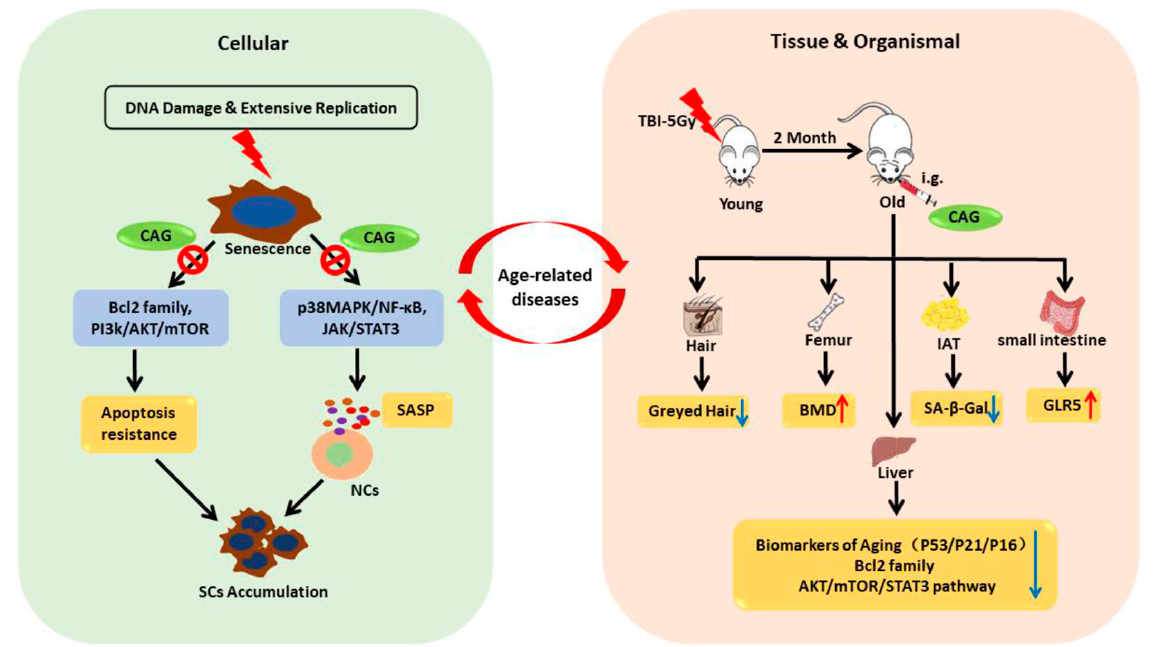
Figure 6. Illustration summarizing the key points of our findings. The accumulation of senescent cells is one of the causative processes of aging, while the aging of tissues and organs also promotes the accumulation of SCs. CAG selectively induces SCs apoptosis via inhibition of Bcl-2 and the PI3K/AKT/mTOR pathway. CAG also suppresses the development of the SASP in SCs,